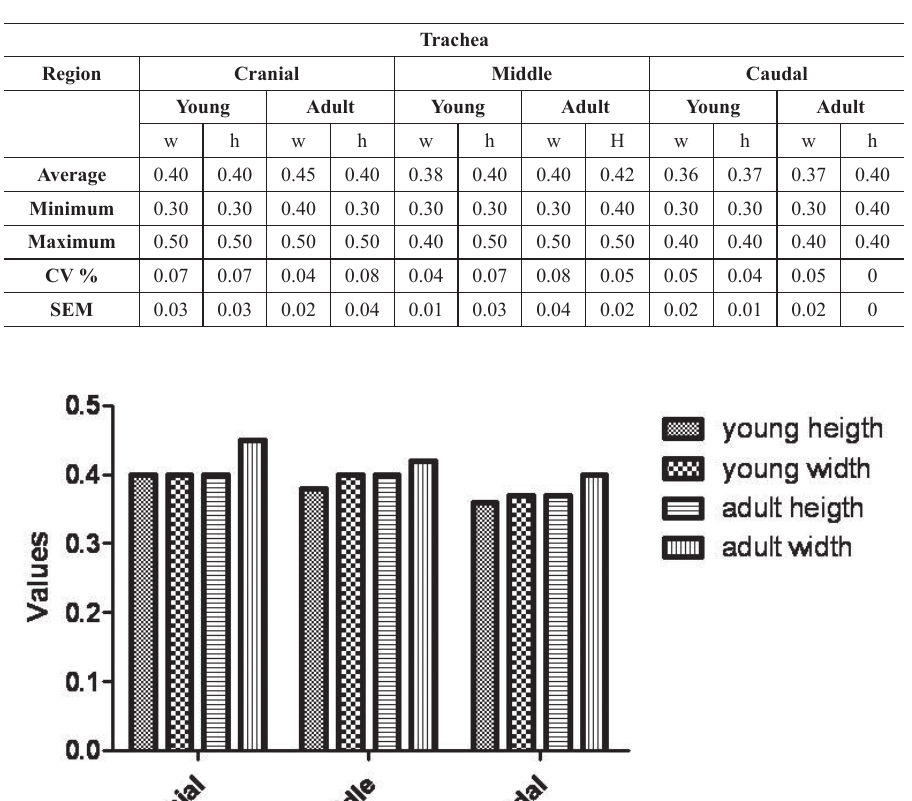
Mean values and standard deviation for width (w) and height (h) (cm) in three parts of the trachea of Saimiri sciureus .